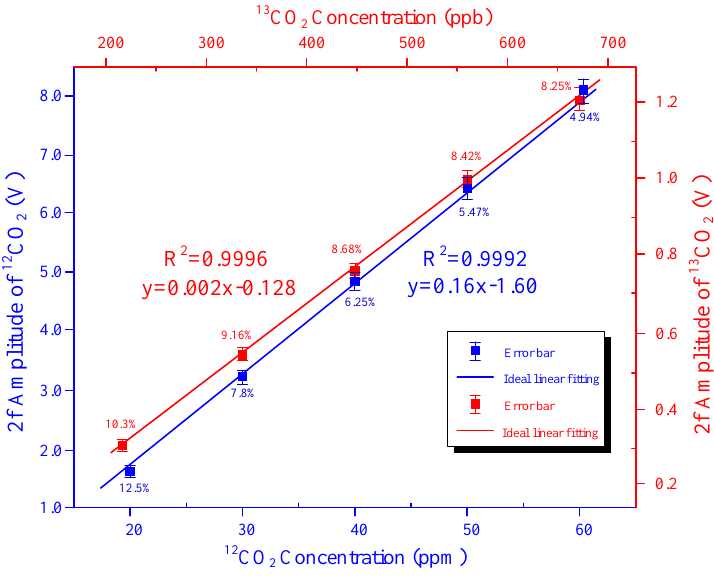
Figure 7. Measured concentration data points and linear fitting curves of the CO 2 concentration versus 2f amplitude value.